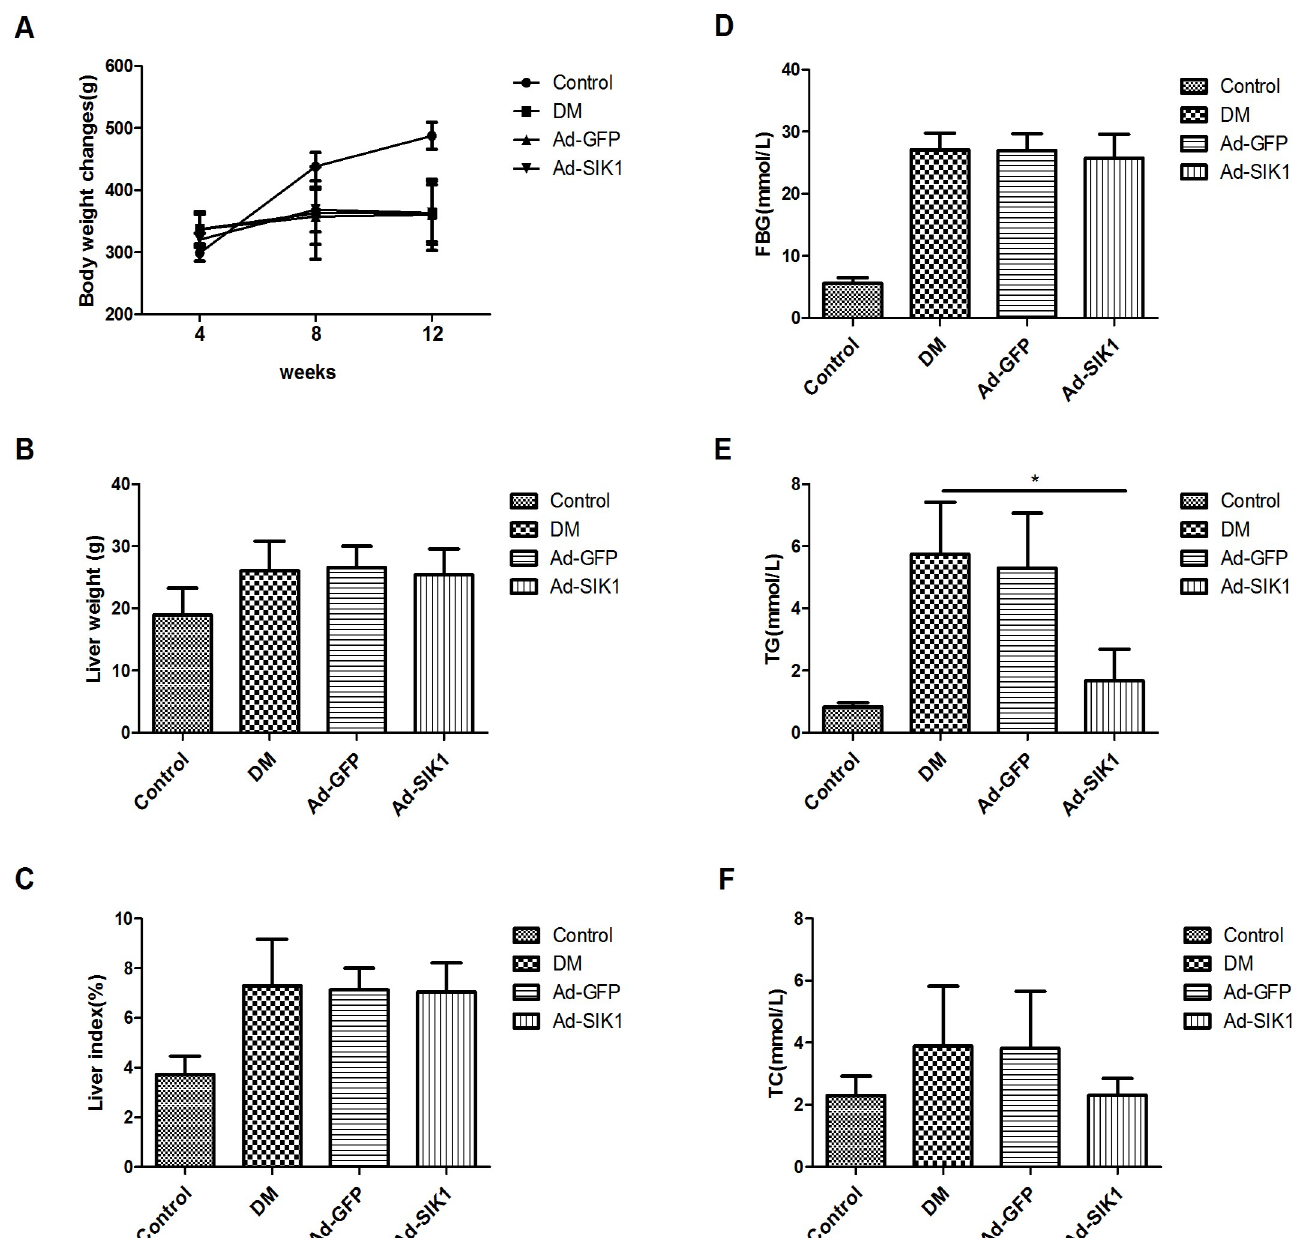
Fig 1. Effects on body weight, liver weight, FBG, TG and TC in HFD/STZ-induced diabetic rats. (A) Changes of body weight in different groups; (B) Liver weight; (C) Liver index; (D) Serum glucose levels; (E) Serum TG levels; (F) Serum TC levels. The results are expressed as the mean ± SD. Significant differences are indicated as � P < 0.05, �� P < 0.01, ��� P < 0.001. ns, not significant. n = 6 in the control group; n = 5 in the DM group; n = 5 in the Ad-GFP group; n = 6 in the Ad-SIK1 group. Control, non-diabetic control rats fed a normal diet; DM, untreated HFD/STZ-induced diabetic rats; Ad-GFP, HFD/STZ-induced diabetic rats treated with Ad-GFP; Ad-SIK1, HFD/STZ-induced diabetic rats treated with Ad-SIK1.